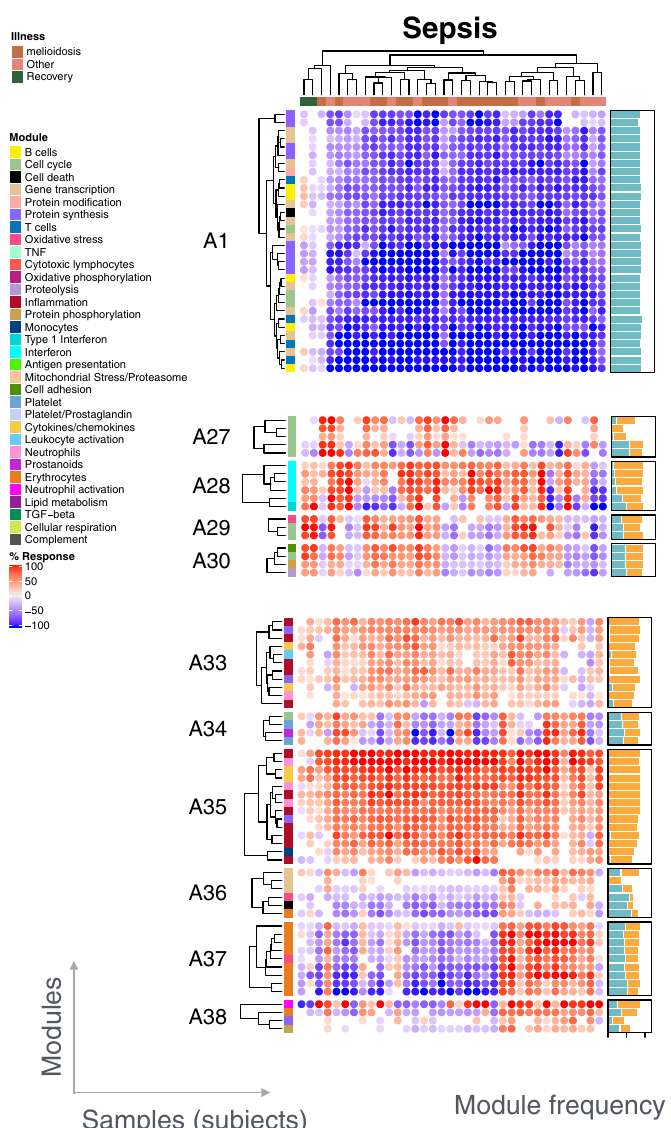
Fig. 5 Individual-level module heatmap. Changes in transcript abundance were determined at the individual level across all modules constituting the repertoire. These changes are represented on a heatmap, where an increase in abundance of a given module is represented in red, and a decrease in abundance is represented in blue. The subjects are organized as columns and the modules as rows. The order on the heat map was determined by hierarchical